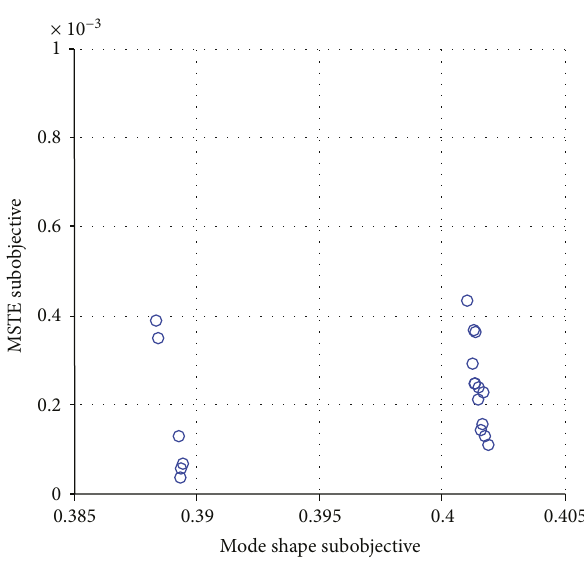
Figure 10: Optimal front obtained from MOLFPSO/TOPSIS in damage scenario 2 under noisy